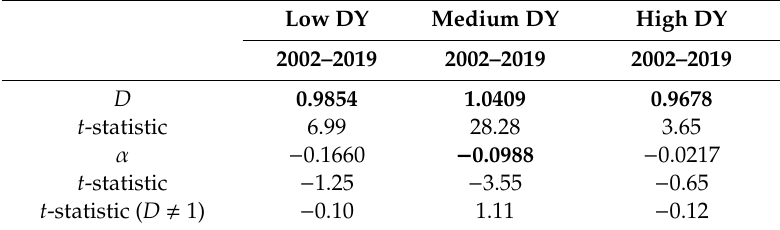
Table 3. Price-drop ratio on the ex-date (dividend-yield (DY) tertiles).